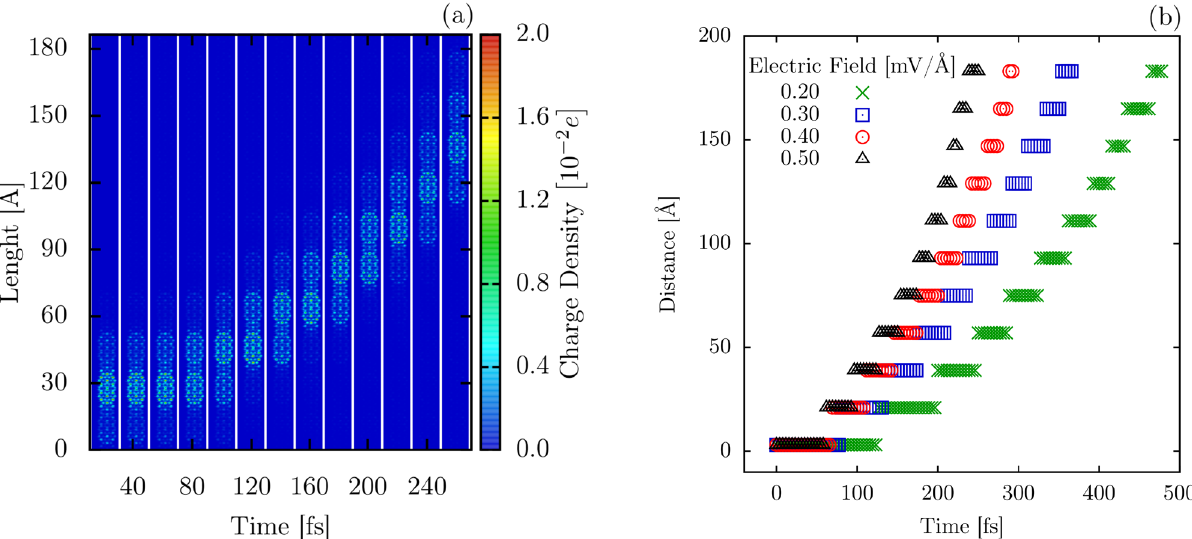
Figure 4. Time-dependent polaron dynamics for 7,9-GNR nanostructure with external electric field presence E = 0.3 mV/Å ( a ) and time-evolution of the charge center ( x p ) for different electric field regimes ( b